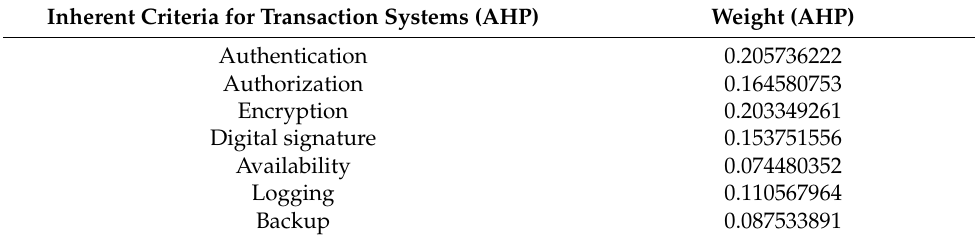
Table 6. Weights of inherent criteria of transaction systems obtained by the AHP.